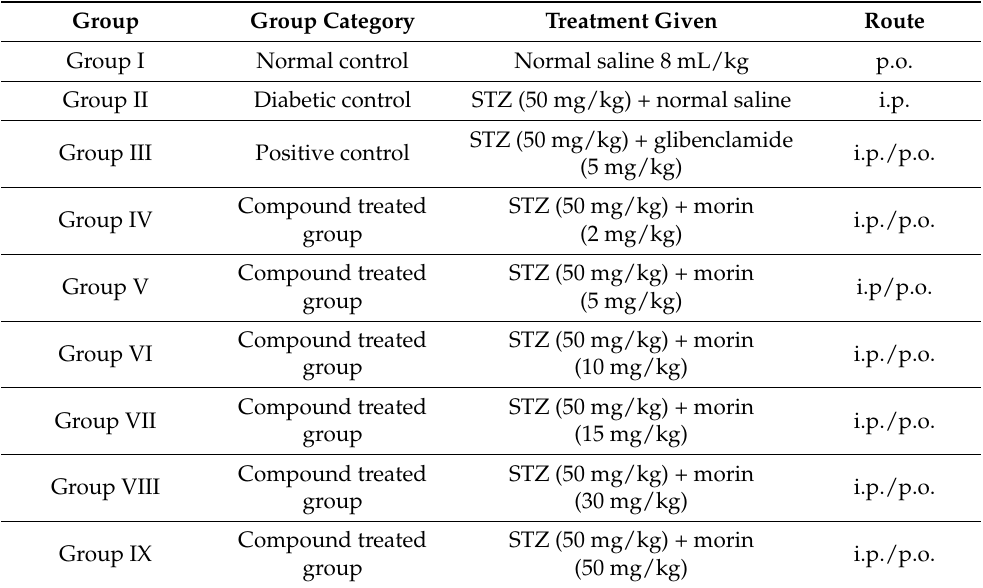
Table 1. Experimental design and various treated groups used in in vivo study. Group Group Category Treatment Given